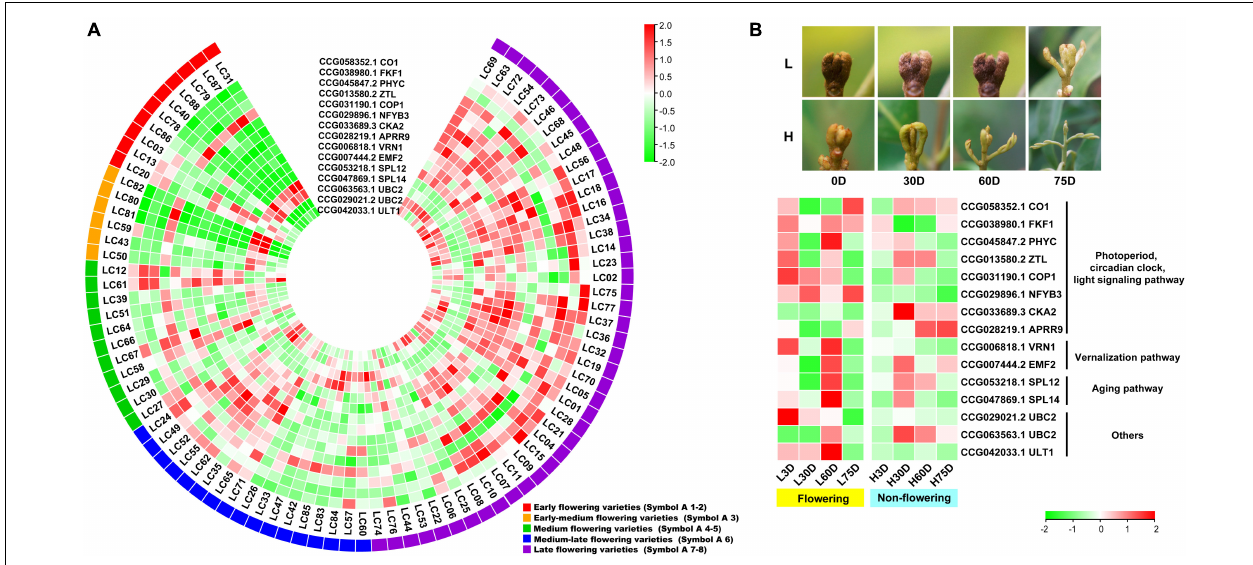
FIGURE 3 | Heat map diagram of the expression of the flowering-related CAGs. (A) Heat map of the expression levels of the flowering-related CAGs in the 87 litchi accessions. Symbol 1–2, 3, 4–5, 6, 7–8 indicate the early (red), the early-medium (orange), the medium (green), the medium-late (blue), and the late flowering accessions (purple), respectively. (B) Morphology of the buds and heat map diagram of the expression levels of the CAGs of the ‘Nuomici’ litchi trees under high temperature (25/20 ◦ C, day/night temperature, 12 h day and 12 h night) and low temperature (15/8 ◦ C, day/night temperature, 12 h day and 12 h night) conditions. L3D, L30D, L60D, and L75D indicate 3, 30, 60, and 75 days of the low-temperature treatment, respectively. H3D, H30D, H60D, and H75D indicate 3, 30, 60, and 75 days of high-temperature treatment, respectively. FPKM values were normalized to Z